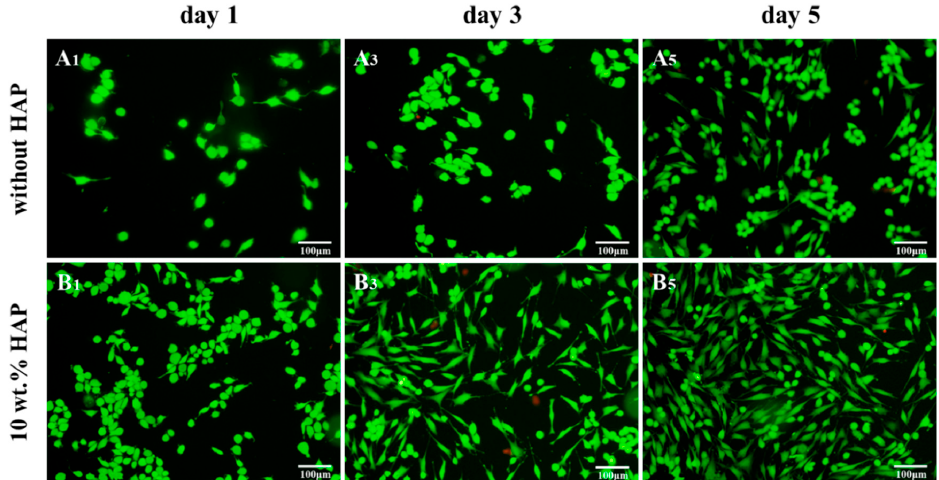
Figure 10. Fluorescence images of MG63 cells cultured on PEEK/PGA and PEEK/PGA-10 wt % HAP scaffolds for different periods (letters A and B correspond to the two scaffolds. Subscripts indicate the time).